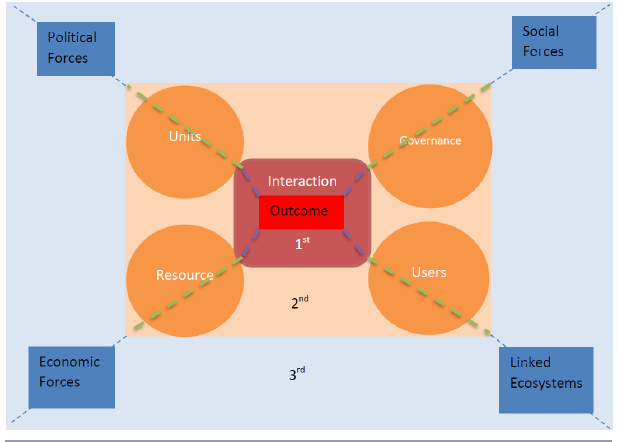
Fig. 1 . Framework for analyzing social-ecological